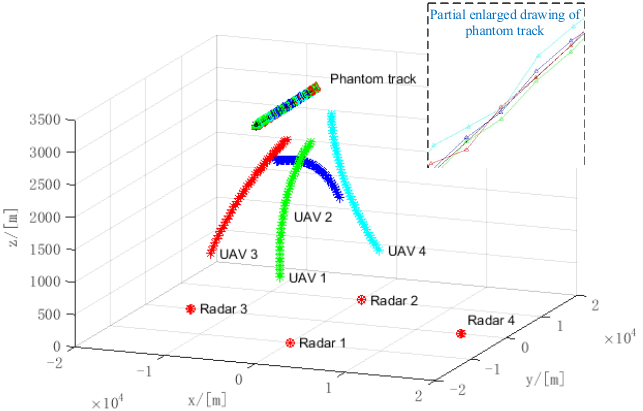
Figure 16. Phantom deception with radar location error and UAV position error (four UAVs).